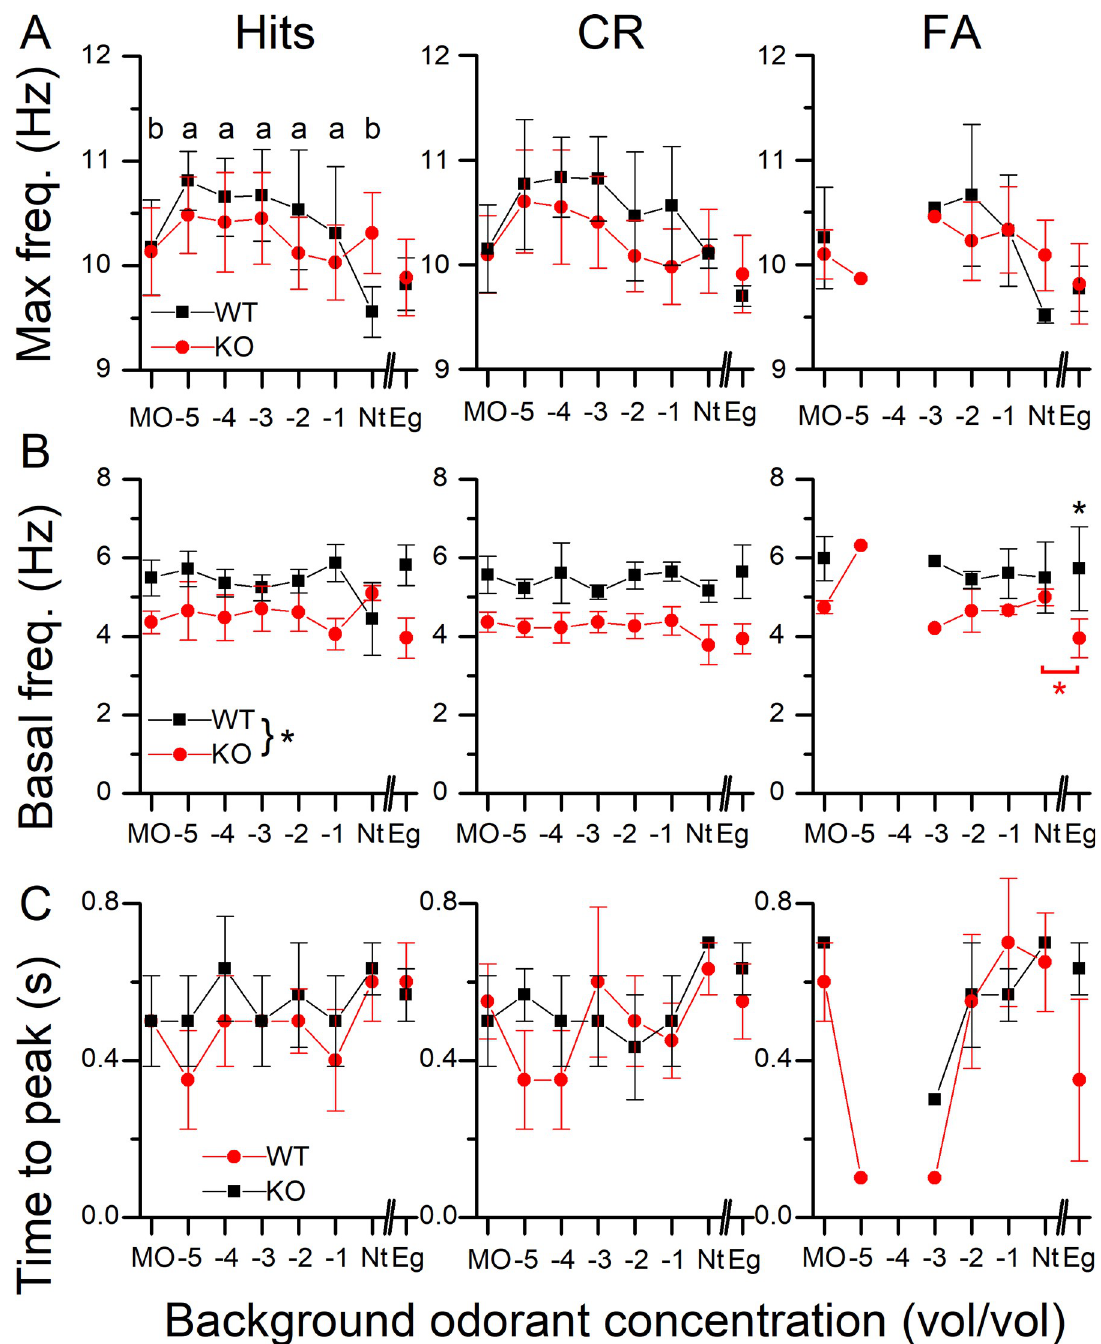
Fig 9. Parameters of sniff responses in the presence of background odorants. A Peak sniff frequency during odorant sampling for WT and NCKX4 KO mice for Hits, CRs and FAs. B Baseline sniff frequency averaged across all sniffs from -1 to 0 s. C Time to reach maximal sniff frequency calculated from the odorant onset at 0.5 s. Max frequency has a significant interaction between genotype and background odorant (F = 3.2, p = 0.006). Also, only in the WT the Max frequency in Nt is significantly lower that of the other concentrations except MO (same letters indicate lack of significance). Max Frequency in MO was different from -5, -4 and -3 in the WT, no differences were seen for the KO. Basal frequency has genotype and behavioral outcome as main effects (F = 9.07, p = 0.02 and F = 3.7, p = 0.027 respectively) with WT different from KO (p = 0.03) and CRs being different from FA (p = 0.028). Time to peak has behavioral outcome and background odor concentration as significant interaction (F = 2.1867, p = 0.021). Data points are averages ± SEM of 3 WT and 4 KO mice. The x-axis displays the log of the odorant concentration.